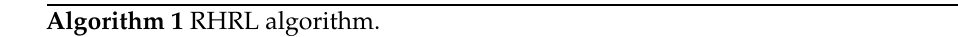
Algorithm 1 RHRL